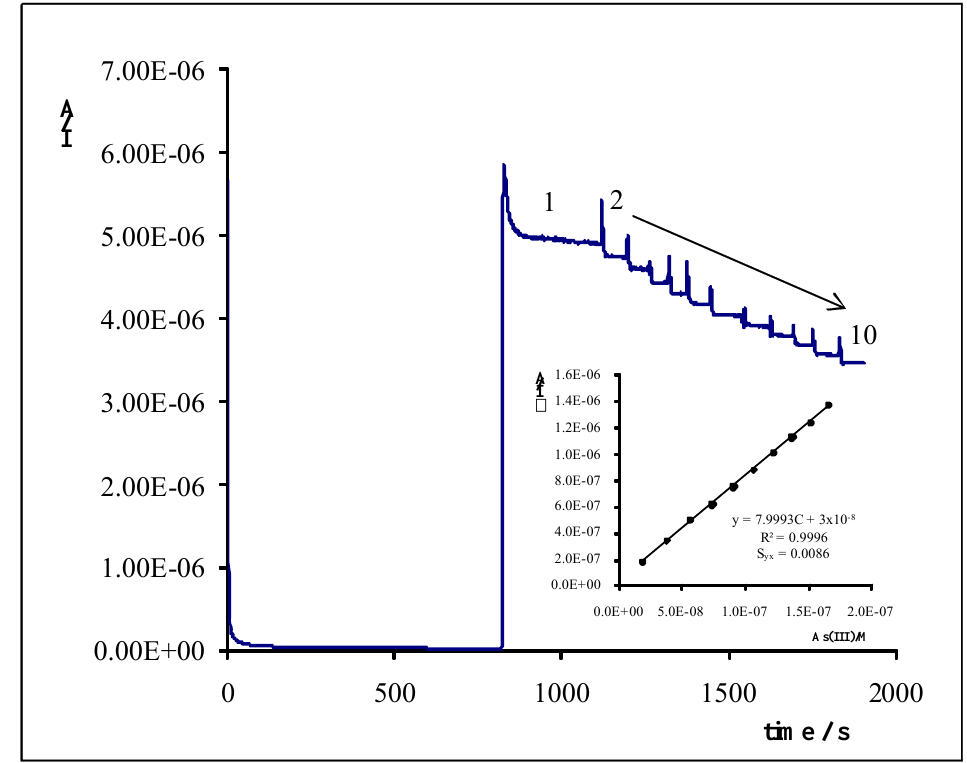
Figure 1. Typical amperometric recording for an acetylthiocholine iodide concentration: (1) 3.64 × 10 -4 M and consecutive addition of aliquots of As(III) solution into the cell to give an overall concentration of: (2) 1.90 × 10 − 8 M, (3) 5.60 × 10 − 8 M, (4) 7.40 × 10 − 8 M, (5) 9.0 × 10 − 8 M, (6) 1.07 × 10 − 7 M, (7) 1.22 × 10 − 7 M, (8) 1.37 × 10 − 7 M, (9) 1.52 × 10 − 7 M and (10) 1.66 × 10 − 7 M. E = 0.6 V vs. Ag/AgCl, Britton-Robinson buffer pH = 7. ap The inset shows the relative calibration